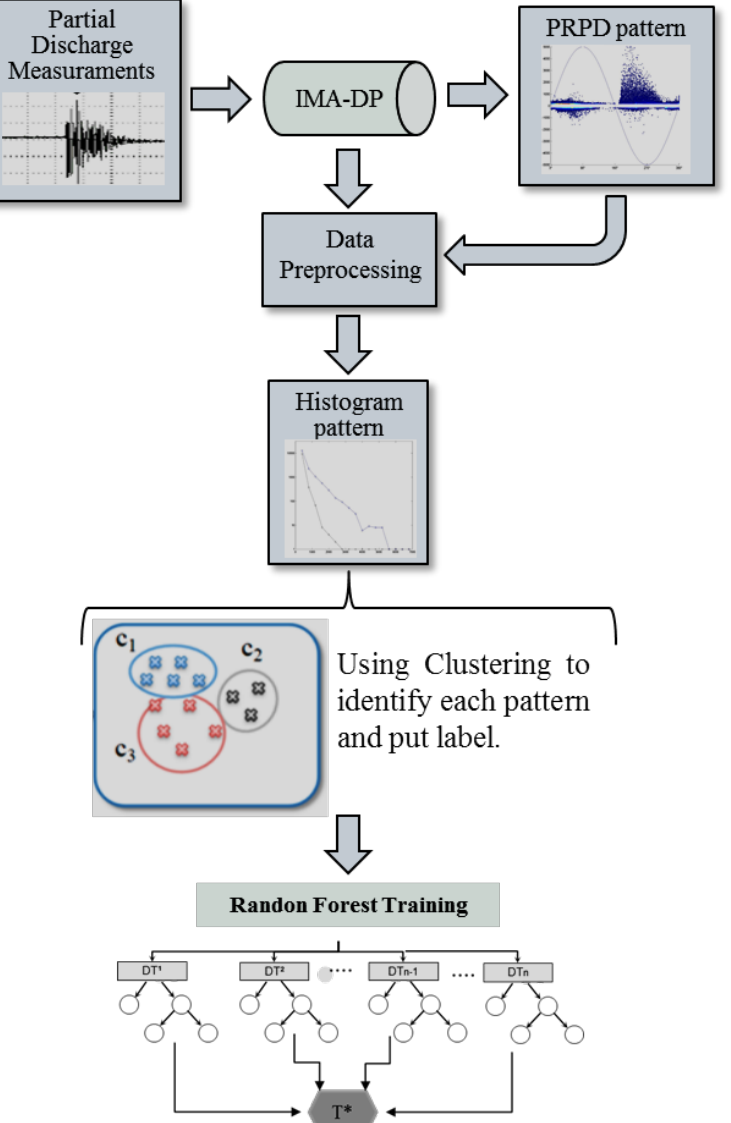
Figure 6. Flowchart representing the step-by-step methodology of partial discharges’ identification.